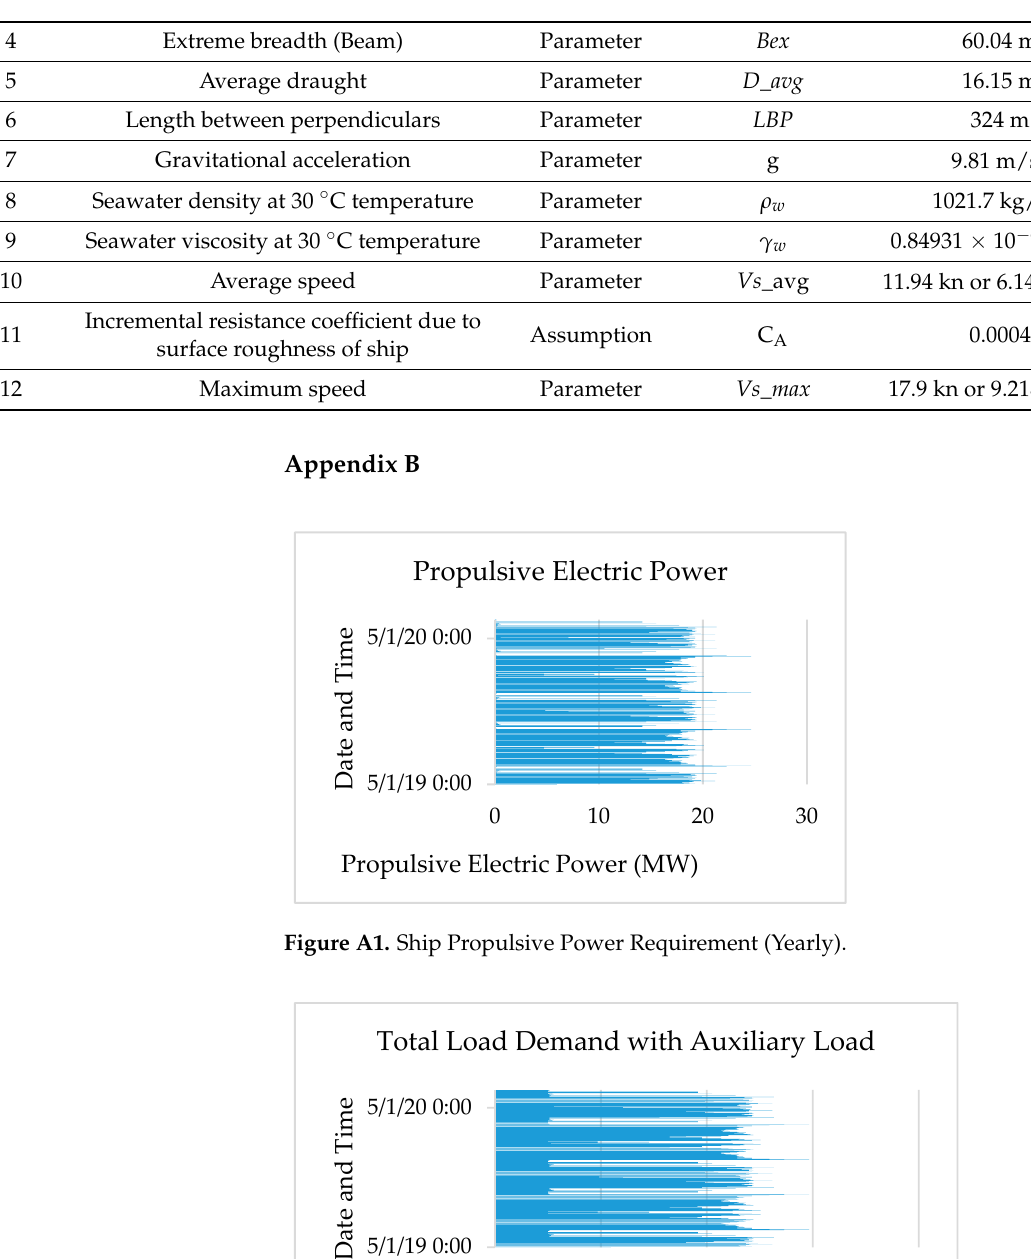
Table A1. Parameters and Assumptions of ‘Baltic Sunrise’. Table A1. Cont.